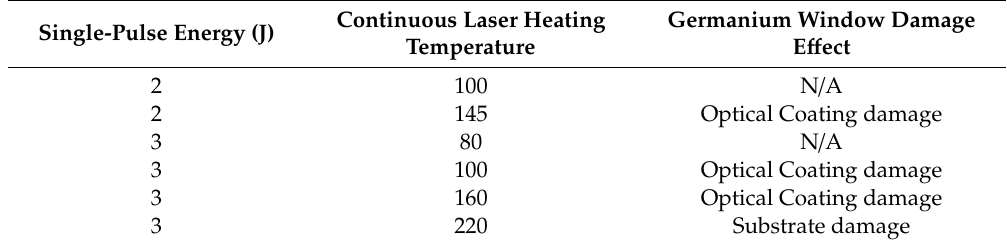
Table 8. Damage phenomenon of the Ge window by the composite